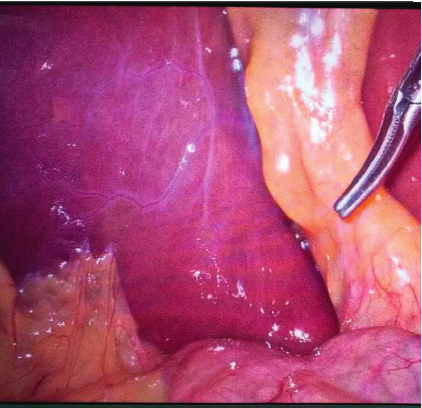
Figure 2: Closed type, oblique